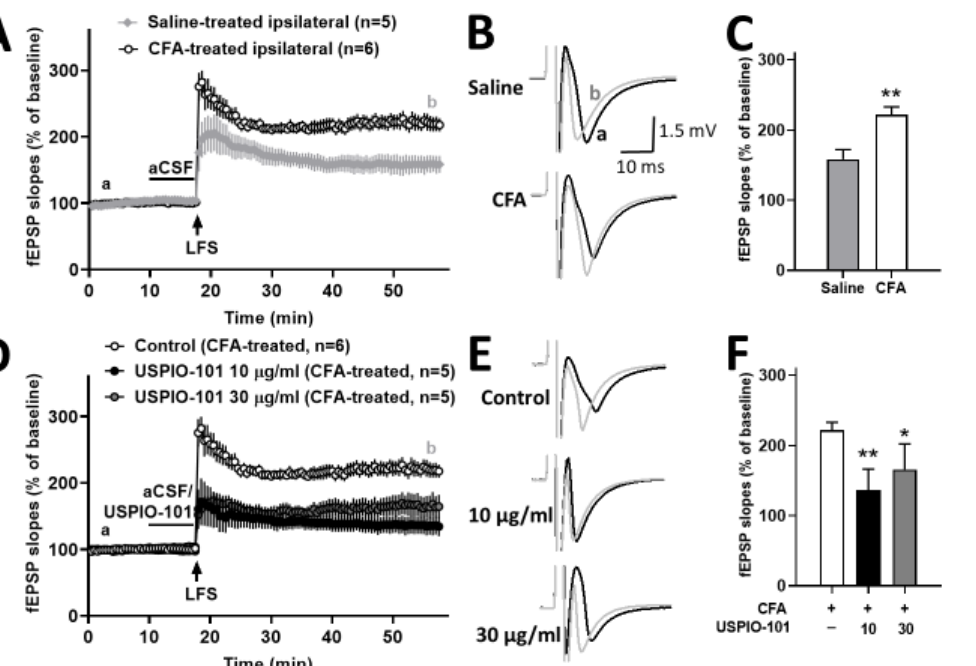
Figure 3. The effect of USPIO-101 on spinal cord LTP in CFA paw-injected mice. ( A ) Time courses of the slope of fEPSPs recorded before and after low-frequency stimulation (LFS, arrow) in spinal cord slices from CFA- or saline-treated mice. ( C ) The bar graph represents the magnitudes of potentiation, which averaged 20 fEPSPs recorded 30~40 min after LFS. **: p < 0.01 (unpaired t -tests) vs. CFA-treated ipsilateral group. ( D ) Time courses of the slope of fEPSPs recorded before and after LFS (arrow) in spinal cord slices from CFA-treated mice with USPIO-101 (10 or 30 µg/mL), respectively. USPIO-101 (10 or 30 µg/mL) applied for 7.5 min before LFS stimulation, respectively. ( F ) The bar graph represents the magnitudes of potentiation, which averaged 20 fEPSPs recorded 30~40 min after LFS at a concentration of 10 or 30 µg/mL. * or **: p < 0.05 or p < 0.01 vs. control group (one-way ANOVA). ( B , E ) Twenty recorded fEPSPs at time points a and b were averaged in each group. The slope of each fEPSP was expressed as % of the baseline fEPSP slope, which was the average of 20 fEPSPs at the beginning of 10 min recording. n indicates the number of slices recorded.